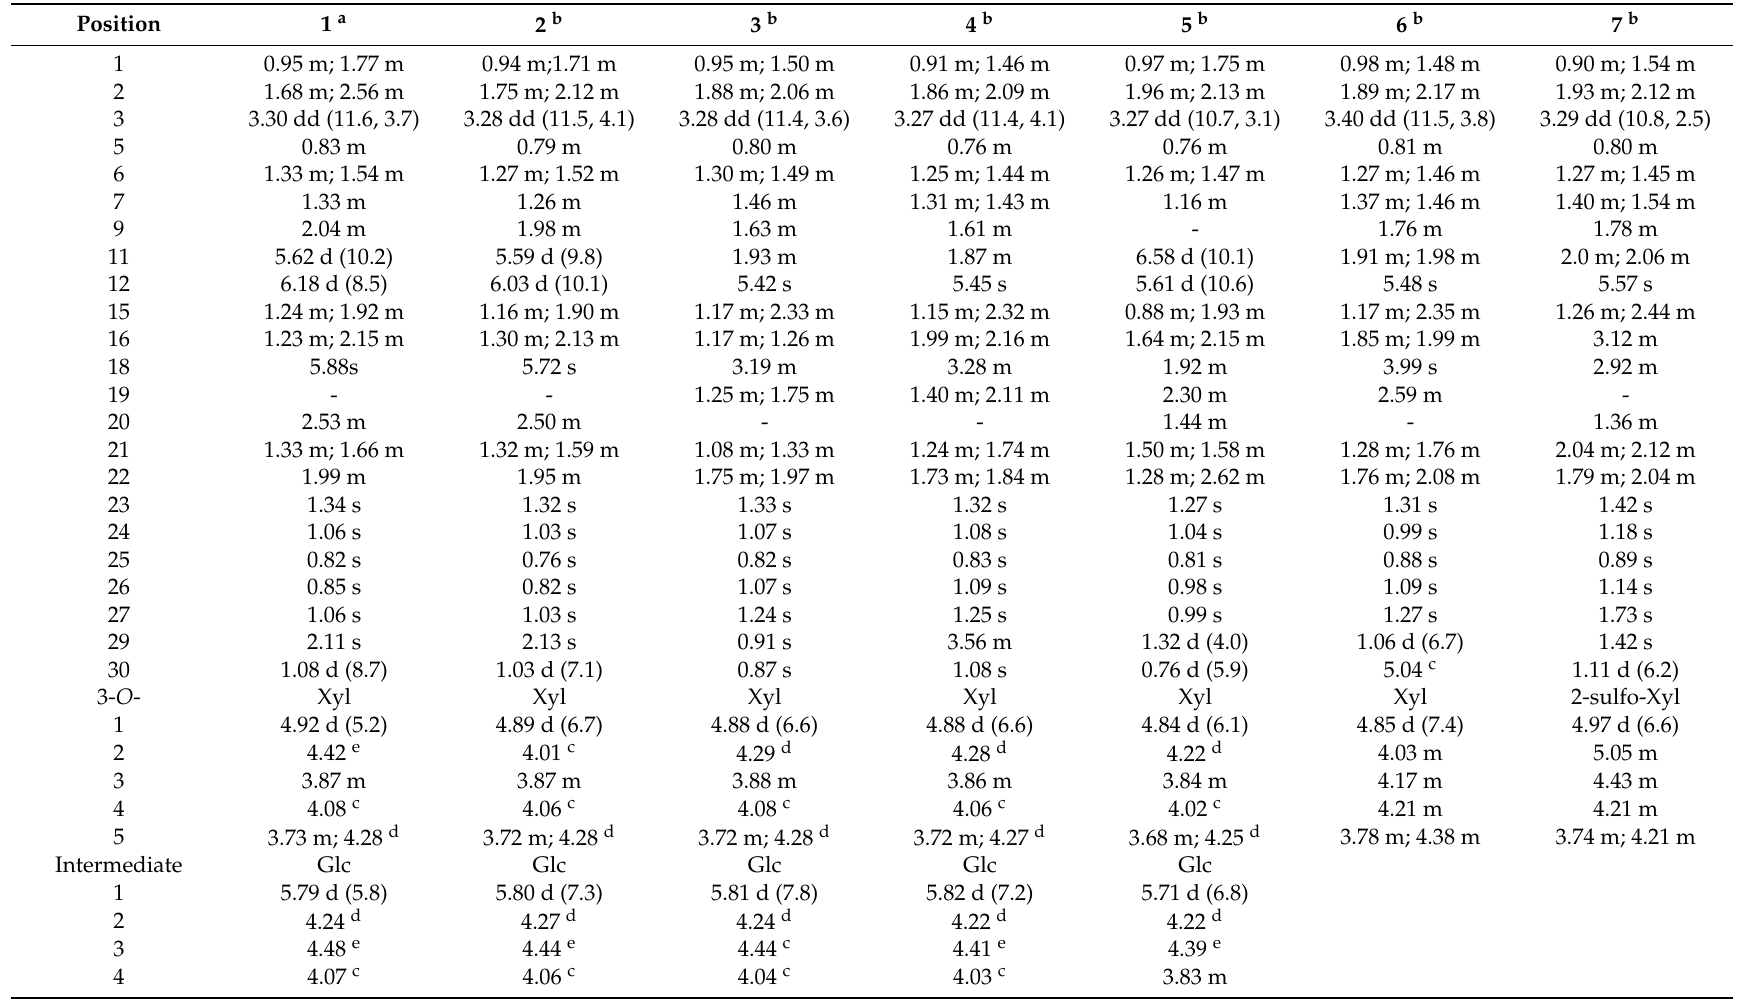
Table 1. 1 H NMR spectroscopic data of compounds 1 – 7 (in pyridine- d 5